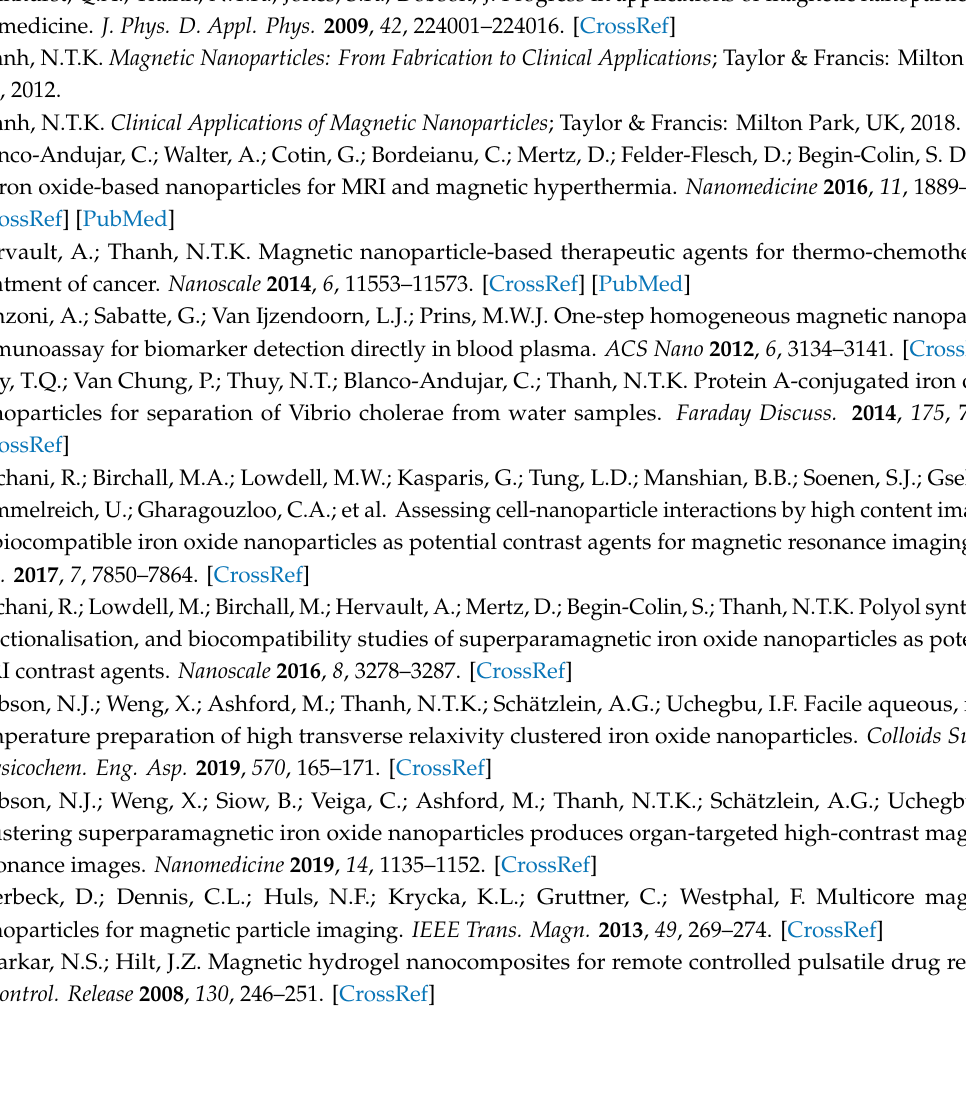
Table S1: Parameters used in the model